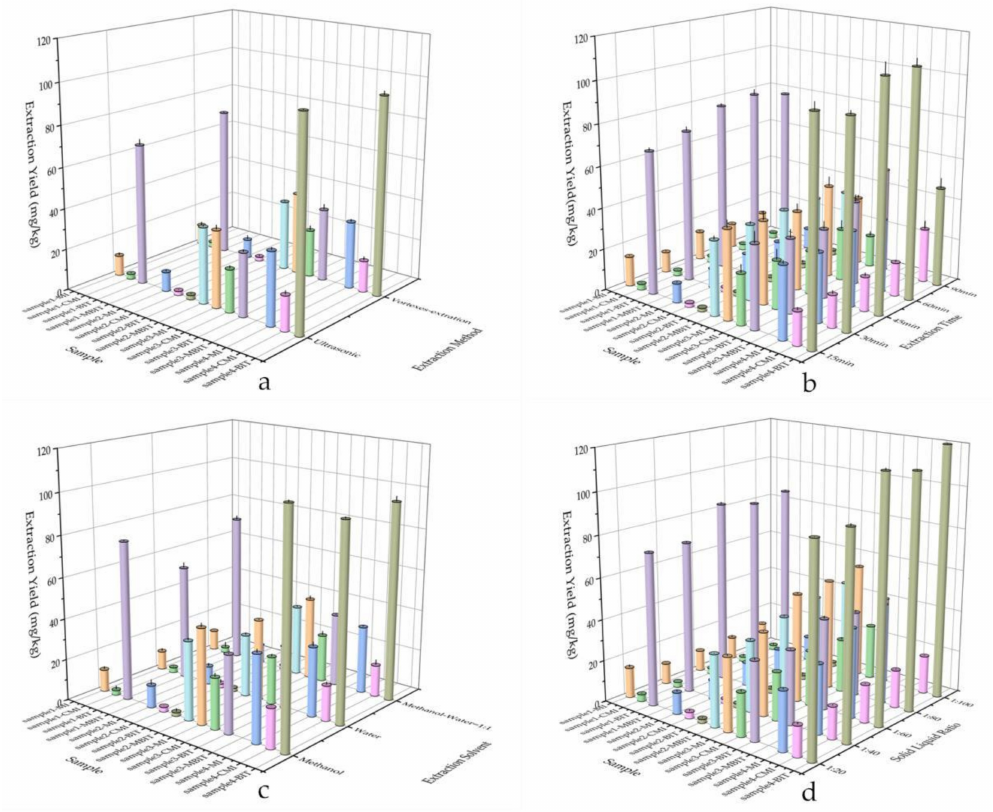
Figure 2. Optimization of extraction of isothiazolinones in adhesives: ( a ) the extraction e ffi ciency of isothiazolinones by di ff erent extraction method; ( b ) the extraction e ffi ciency of isothiazolinones by di ff erent extraction time in vortexes method; ( c ) the extraction e ffi ciency of isothiazolinones by di ff erent solvents; ( d ) the extraction e ffi ciency by di ff erent solid: liquid ratio (methanol) in vortexes method. (The standard deviations were used as error